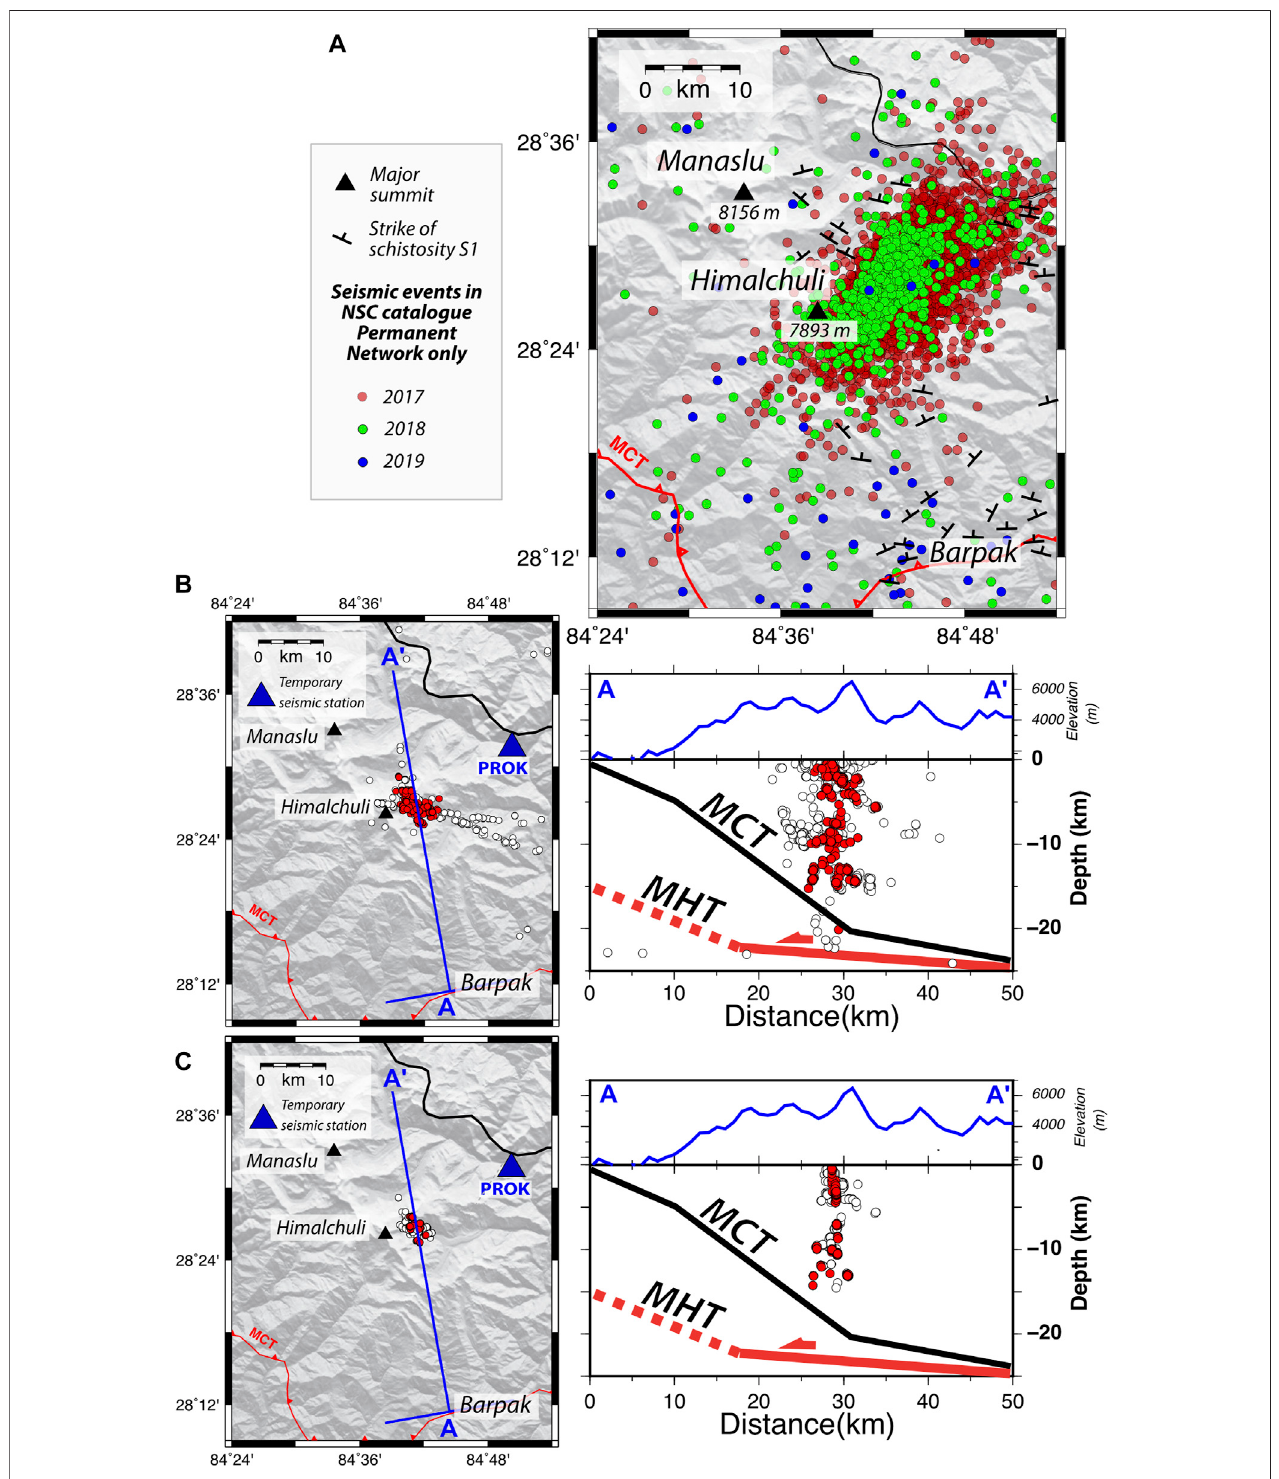
FIGURE 3 | (A) Seismicity recorded by the permanent NSC network. Red, green, and blue circles correspond to events recorded in 2017, 2018, and 2019, respectively. The red contour corresponds to the surface trace of MCT. (B) Map and cross section through the seismic events detected using template matching and relocatedincludingatleastonetemporarystation(PROKorJL).OpencirclesshowalltheeventslocatedwithHypo71;redcirclesshowtheeventslocatedwithatleast9 phases. (C) Map and cross section through the best events relocated using HypoDD.